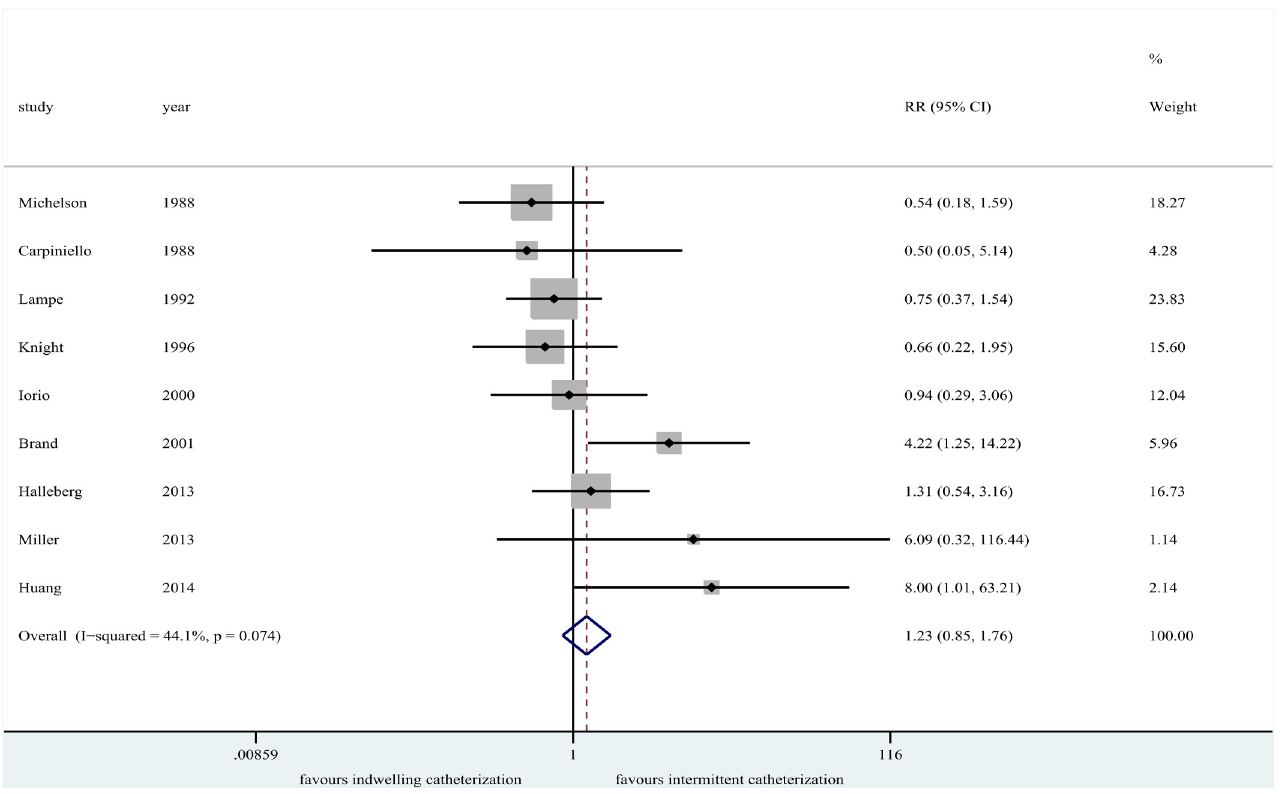
Fig 2. Forest plot for urinary tract